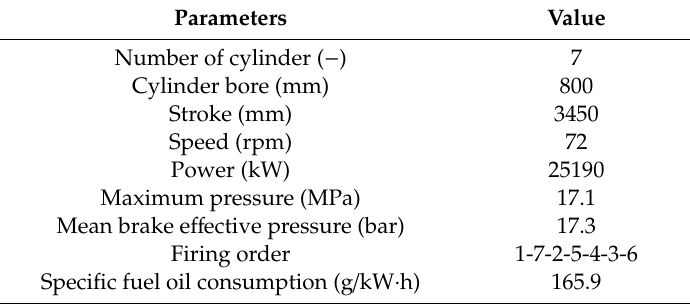
Table 1. Main Technical parameters of 7S80ME-C9.2 diesel engine at MCR (Maximum Continuous